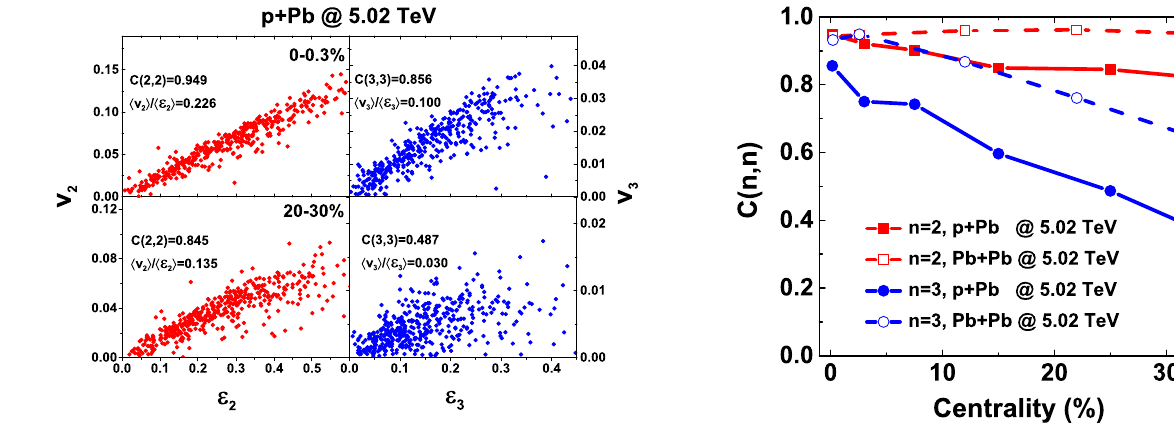
Fig. 14 Correlationcoefficient C ( n , n ) as afunction ofcentralityclass in 5.02 TeV p + Pb collisions for n = 2 and 3, compared to calculations in Ref. [15] in 5.02 TeV Pb + Pb